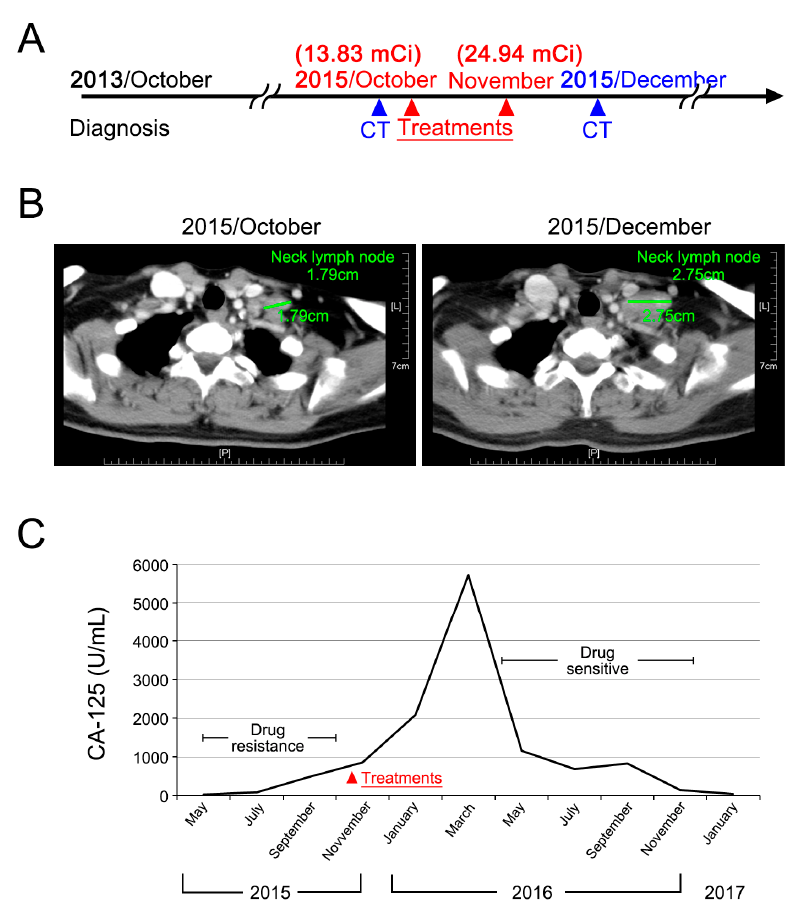
Figure 7. Case 2 presentation of a 188 Re-liposome phase I trial. ( A ) Clinical treatment scheme; ( B ) CAT scan imaging before and after 188 -Re-liposome treatment. Enlargement of supraclavicular lymph nodes is presumed to be due to the acute inflammatory reaction of lymph nodes; ( C ) Monitoring of serum CA-125.